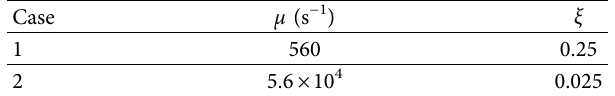
Figure 1: Geometry and FE model of the cantilever beam. Table 1: Values of damping parameters for different levels of nonviscous effect.